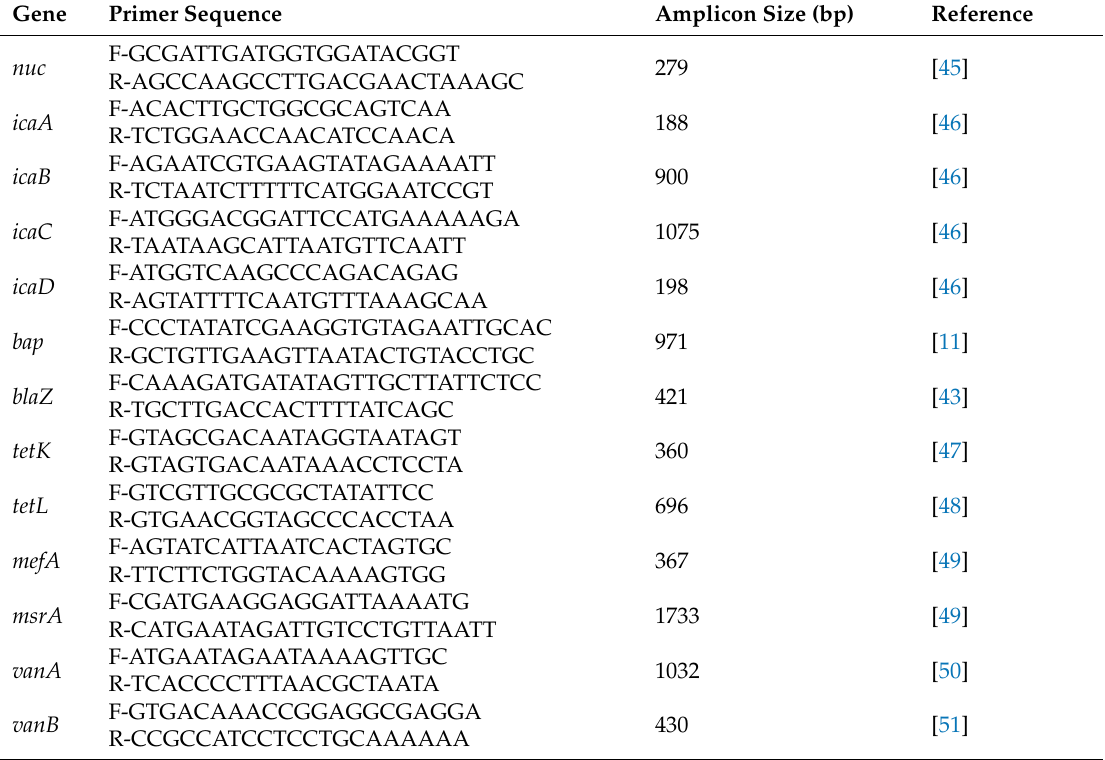
Table 5. Putative virulence and resistance genes and primer sequences used in this